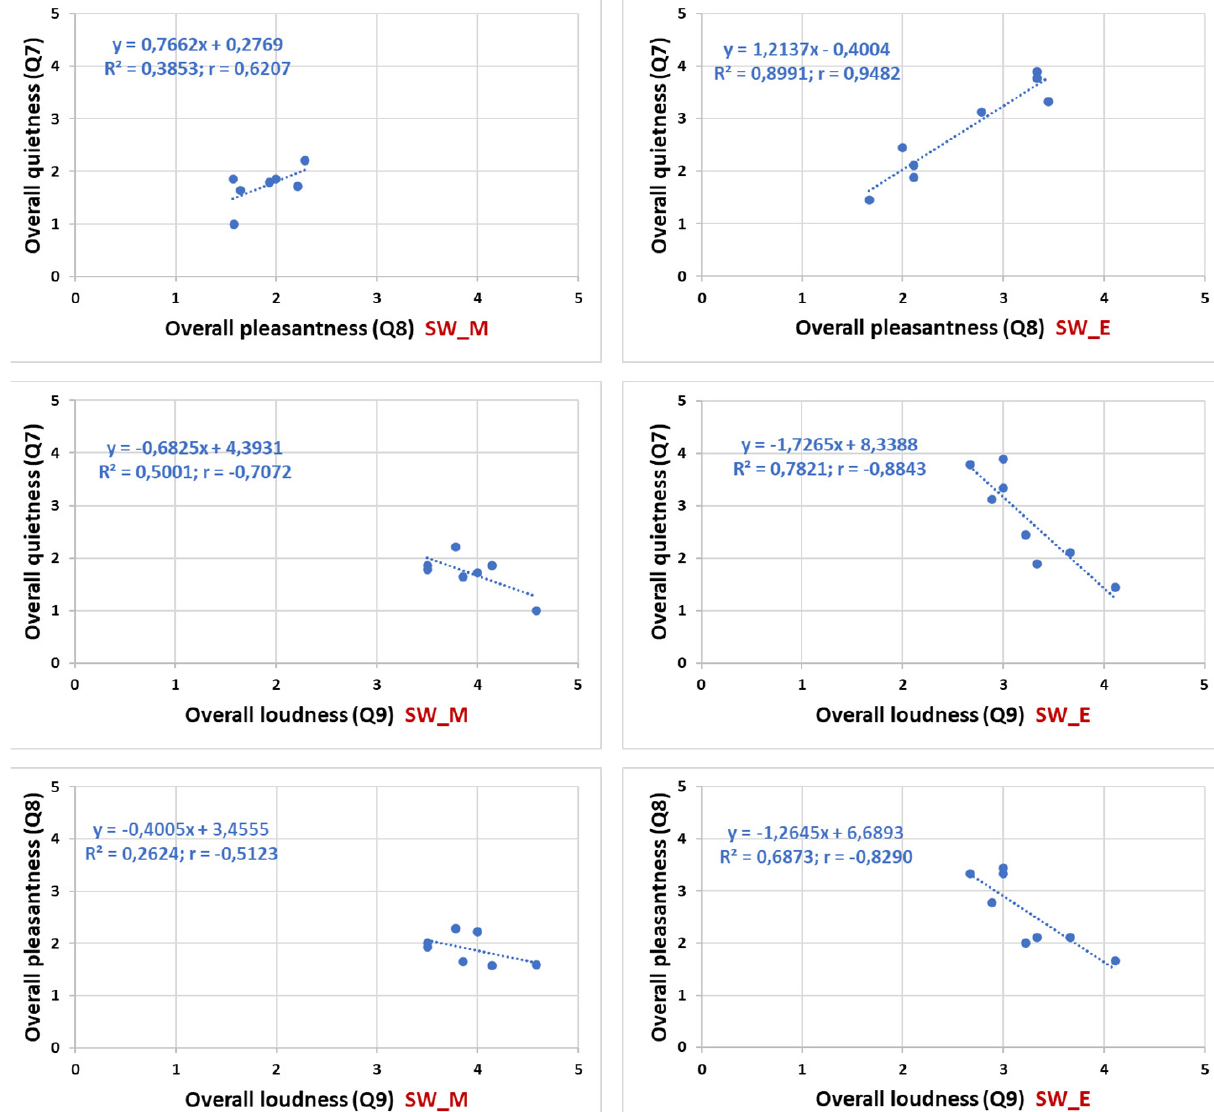
Figure 19: Overall quietness (Q7), pleasantness (Q8) and loudness (Q9) correlations during the morning (left) and evening (right) sound-